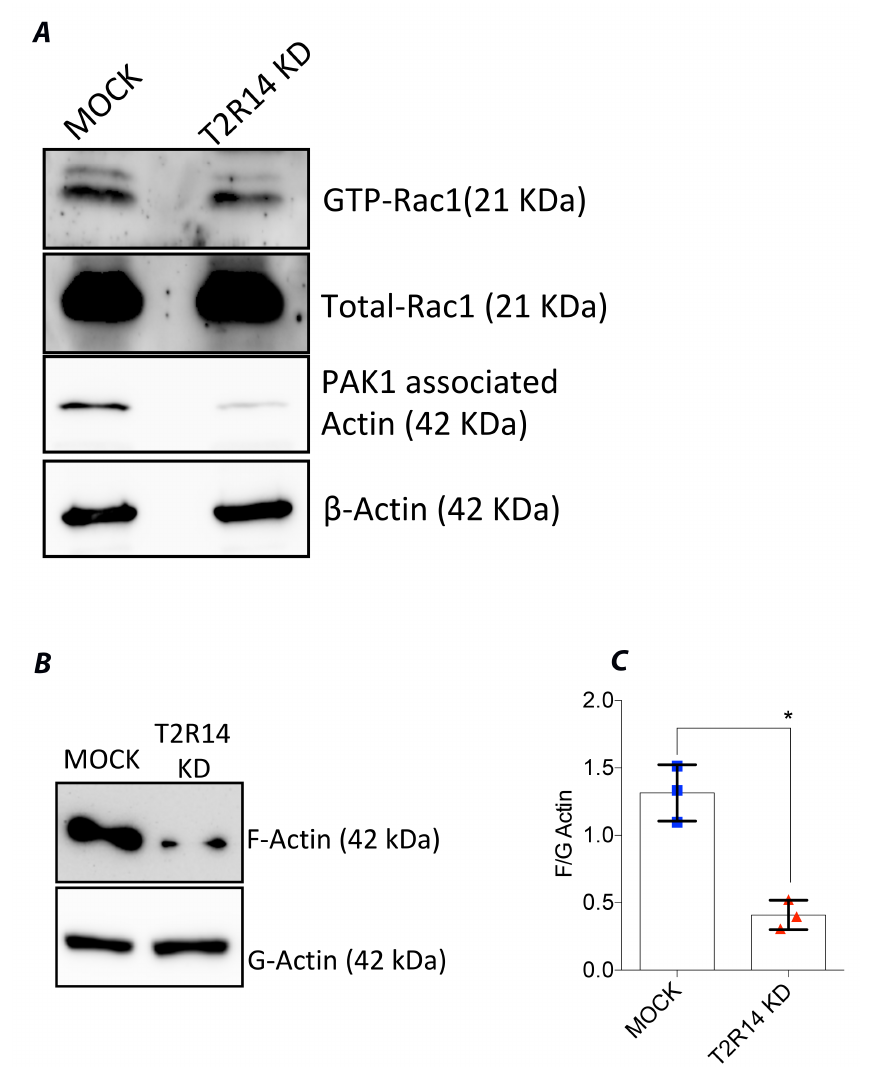
Figure 2. Characterizing the GTP-Rac1, F/G actin levels in MOCK and T2R14 KD OKF6 cells. ( A ) The MOCK and T2R14 KD OKF6 cell lysates (500 µ g) were incubated with PAK1 agarose beads (20 µ g) for 1 h at 4 ◦ C. After incubation the beads were washed, re-suspended in 2 × Laemmli buffer and separated by 12% SDS-PAGE. Western blot analysis of PAK1 pull-down and total protein lysates using primary mouse monoclonal anti-Rac1 antibody (1:1000), mouse monoclonal anti β -Actin antibody (1:25,000) and secondary anti-mouse HRP antibody (1:5000 and 1:25,000) re-spectively. To visualize GTP-Rac1 that is at low levels compared to Total-Rac1, the blots were exposed for 5 min. To visualize PAK1 associated Actin and β -Actin the blots were exposed for 1 min. ( B ) Western blot analysis of F and G actin fractions isolated from MOCK and T2R14 KD cells and separated by 10% SDS-PAGE. The blots were probed using primary mouse monoclonal anti β -Actin antibody and exposed for 1 min. ( C ) The corresponding densitometry analysis of F and G actin isoforms. The data represented in the graphs are SEM of ≥ 3 independent experiments. One-way ANOVA analysis, using Tukey’s multiple comparison analysis, was performed, and the observed p-value is * p < 0.05. The blots were developed by using chemiluminescence detection system and imaged by using a ChemiDoc MP imaging system, Bio-Rad, Toronto, ON,